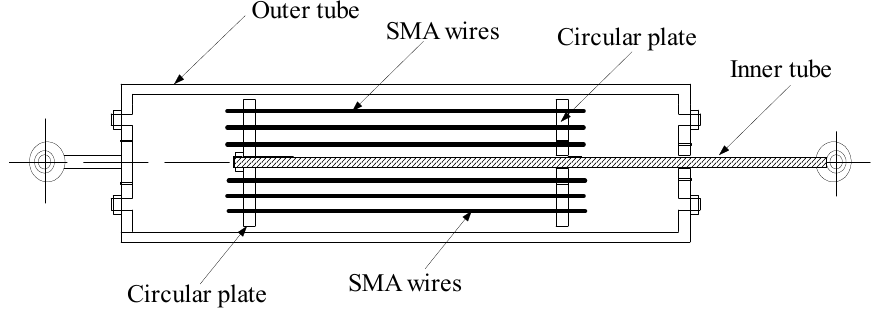
Figure 2. Schematic configuration of SMA damper.